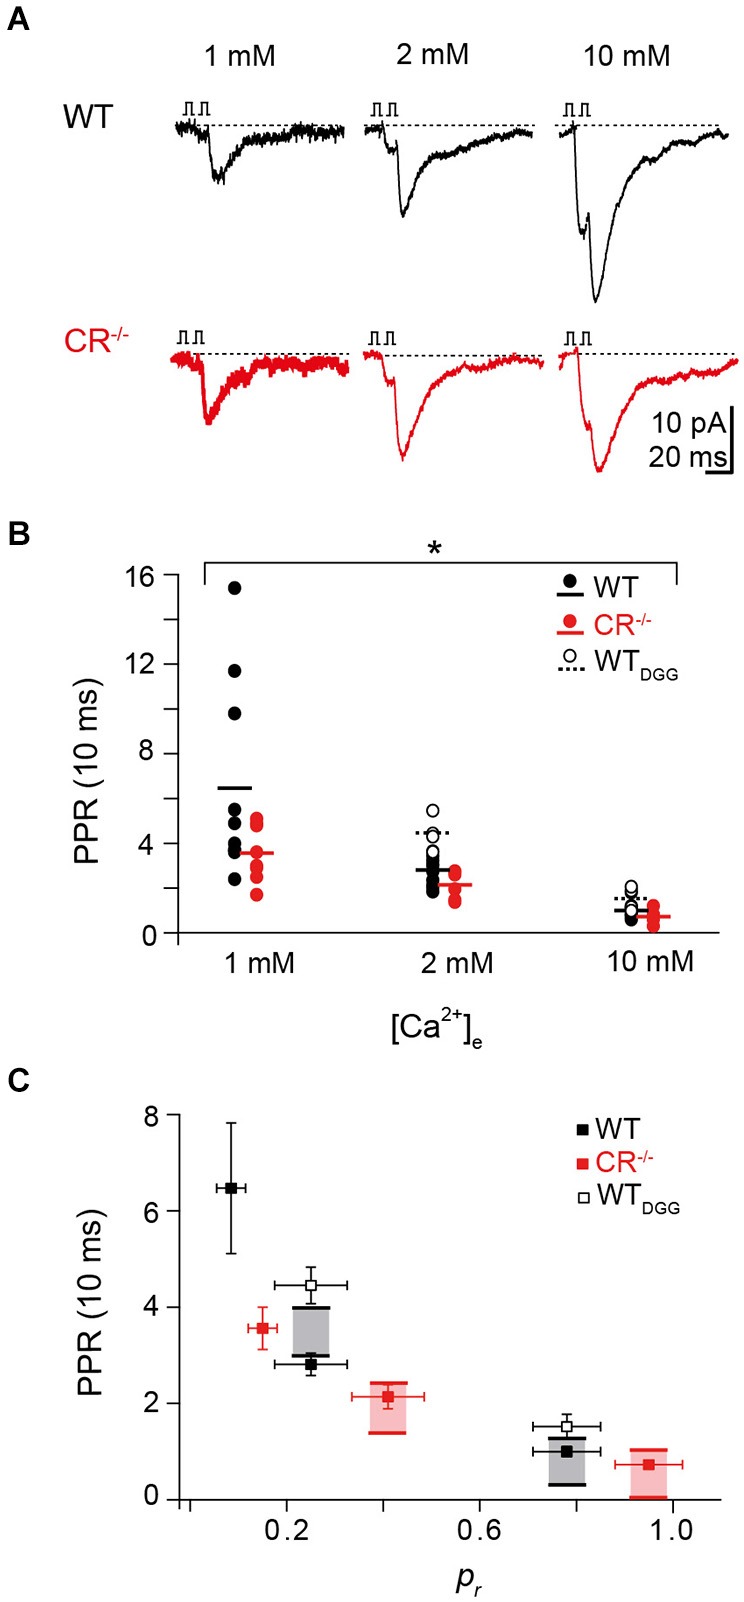
Rapid replenishment and overfilling contribute to PPF. (A) Examples of EPSCs recorded at an ISI of 10 ms at different extracellular Ca2+-concentrations from a representative WT (black) and CR−/− (red) unitary connection. (B) PPR vs. Ca2+-concentration from individual pairs at an ISI of 10 ms for WT (black; solid circles, solid line indicates the average; n = 10), CR−/− (red; n = 8), and WT in the presence of γ-DGG (5 mM, WTDGG; open circles; dashed line indicates average; n = 4). For all [Ca2+]e concentrations tested, PPR in the mutant was significantly smaller than in WT (*P < 0.01, K-W ANOVA). (C) Plot of PPR vs. pr for all [Ca2+]e revealing a decline in PPR with increasing pr in WT and CR−/− (PPR: mean ± SE (cf. Panel B), pr: median ± SE; WT (black): n = 10; CR−/− (red): n = 8). Shaded areas indicate the maximum theoretical values of PPR (PPRmax for pr2 = 1) in presence (top line) and in absence (bottom line) of full vesicle replenishment. PPR values at high pr are close to the theoretical PPRmax with full vesicle replenishment for mutant and WT. PPR values determined in the presence of γ-DGG (open squares, WTDGG: n = 4) exceed the theoretical PPRmax with full vesicle replenishment.